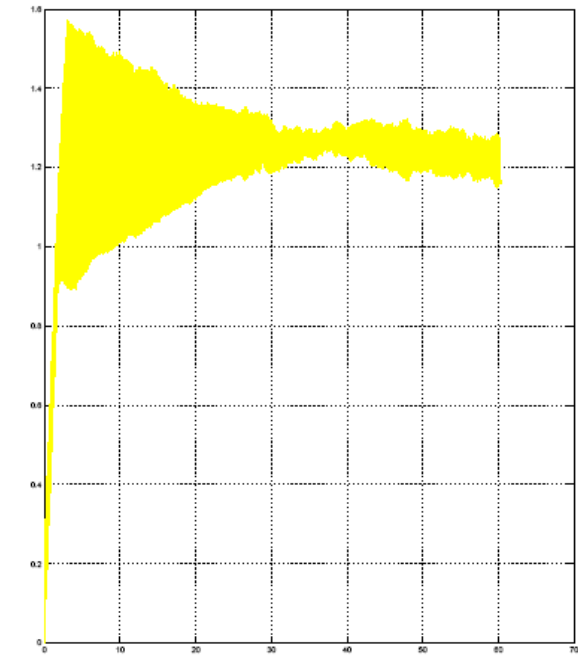
Fig. 2. Simulink® Model of WIP System.